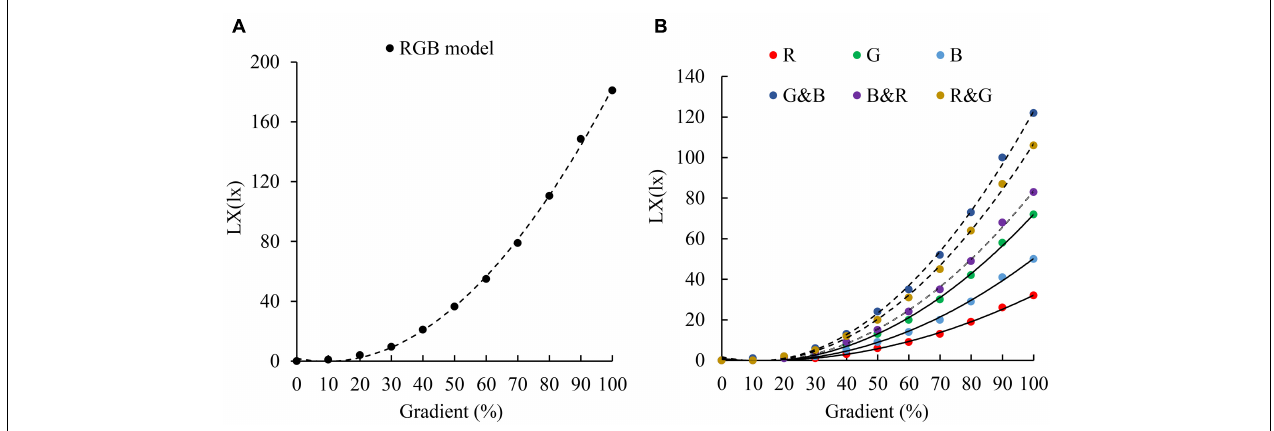
FIGURE 1 | Light intensity adjustment for RGB color model on TFT-LCD display. (A) The quadratic fitting line of light intensity and GMTPC gradients. (B) The quadratic fitting lines of light intensity with TPCs and GMSCs gradients. TABLE 1 | The fitting formula of light intensity with the different gradients of GMTPC, TPC, and GMSC. Color